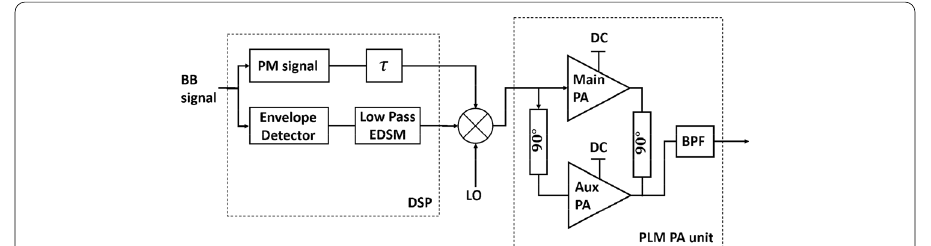
Fig. 1 Diagram of envelope delta-sigma modulation transmitter